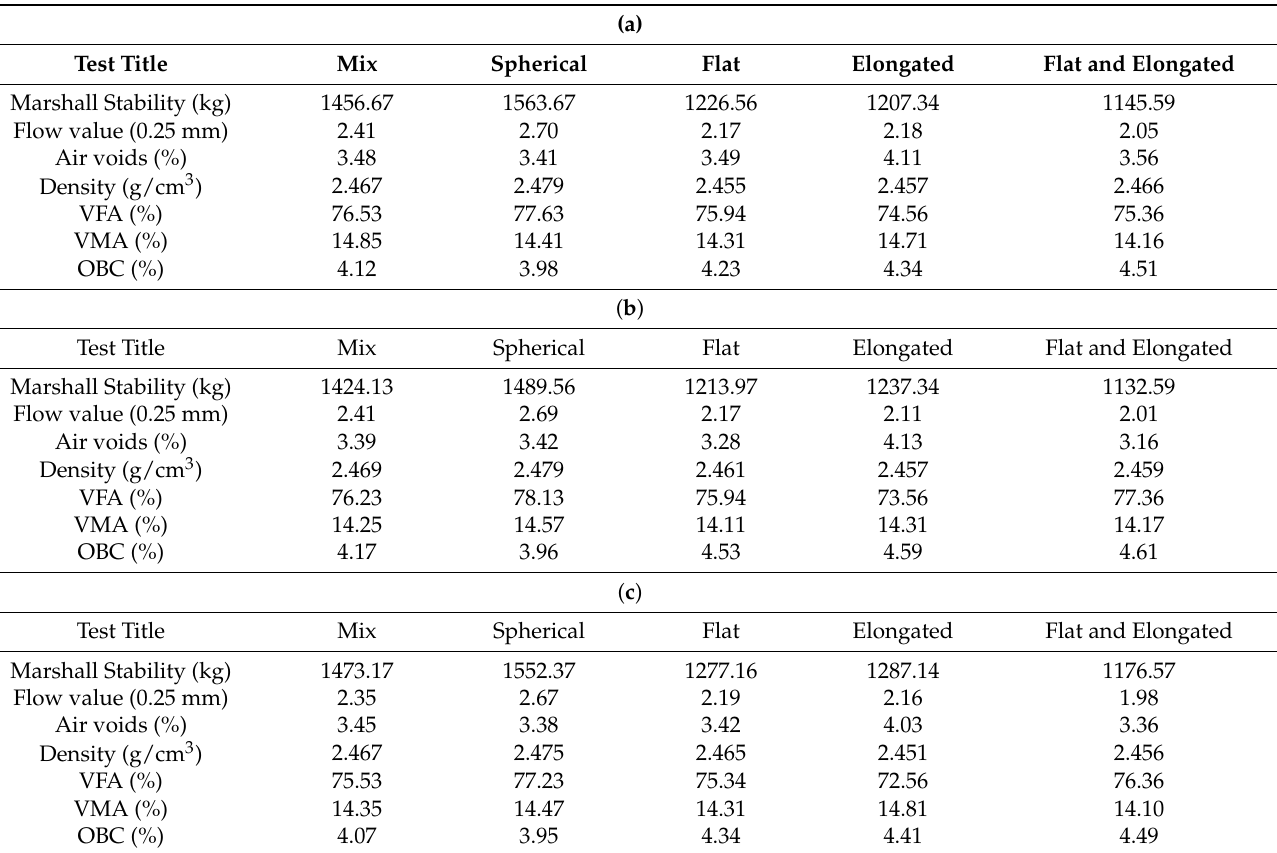
Table 7. ( a ) Volumetric properties of asphalt mixture for aggregates of Ubhan Shah Impact Crusher. ( b ) Volumetric properties of asphalt mixture for aggregates of Margalla Impact Crusher. ( c ) Volumetric properties of asphalt mixture for aggregates of Margalla Jaw